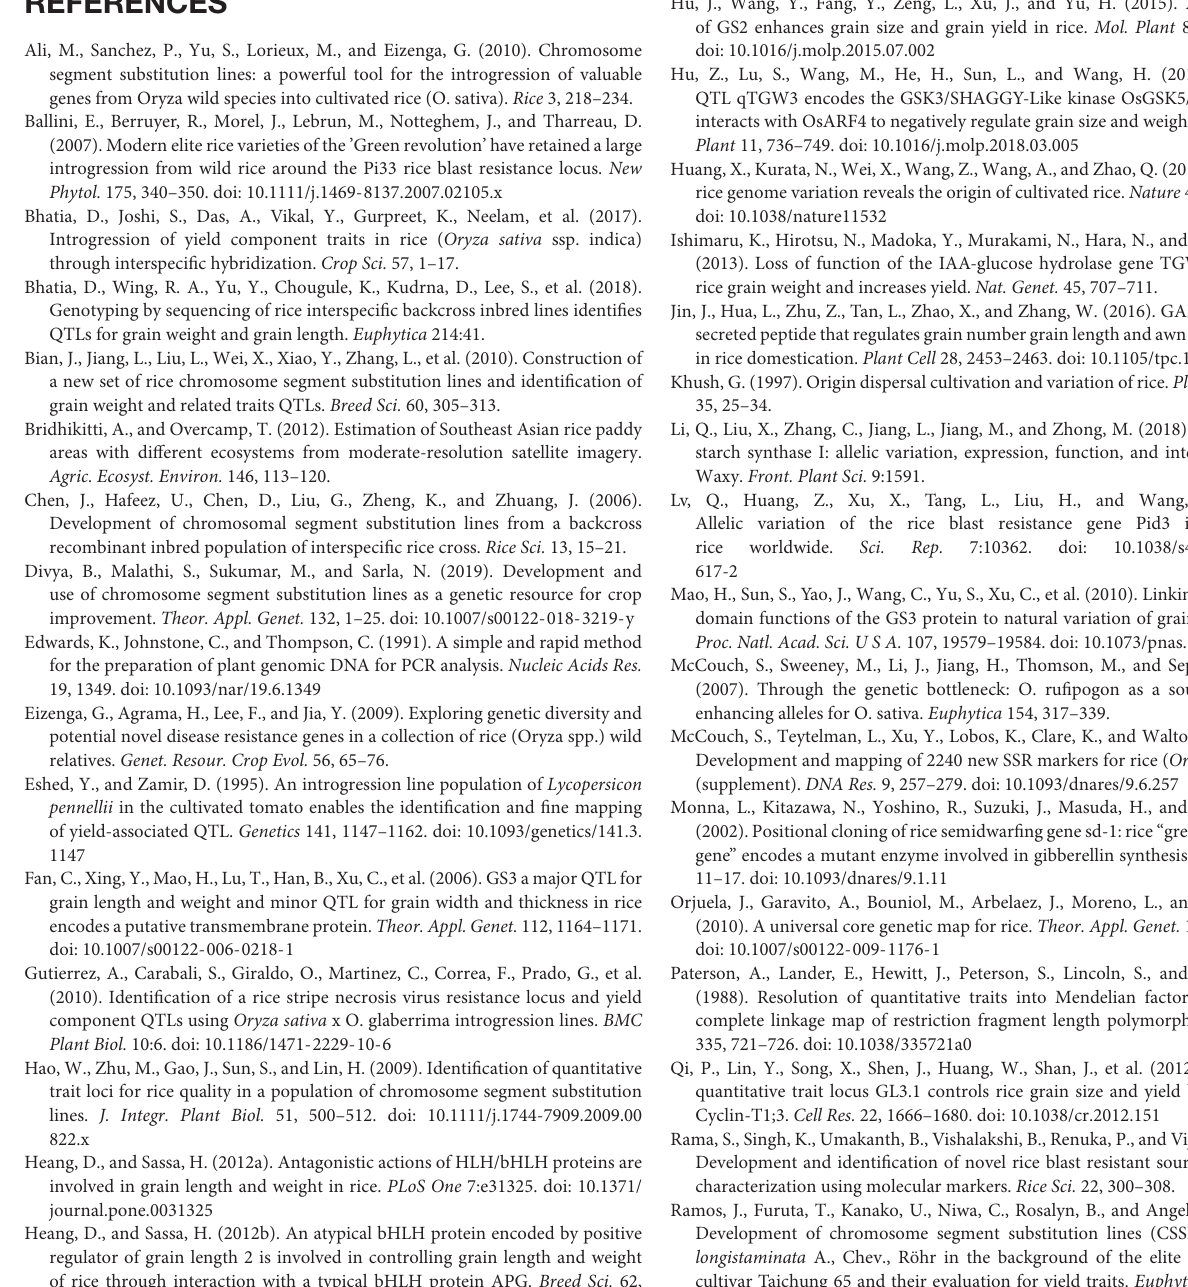
Supplementary Figure 6 | Chromosome segments distribution and coverage degree of introgression library from the donor of O. rufipogon . Each block at the row represented introgression from a total of 74 ILs on the target chromosome, regardless of introgression segments in other chromosomes, and each column represented a molecular marker locus. Supplementary Figure 7 | Chromosome segments distribution and coverage degree of introgression library from the donor of O. glaberrima. Each block at the row represented introgression from a total of 81 ILs on the target chromosome,